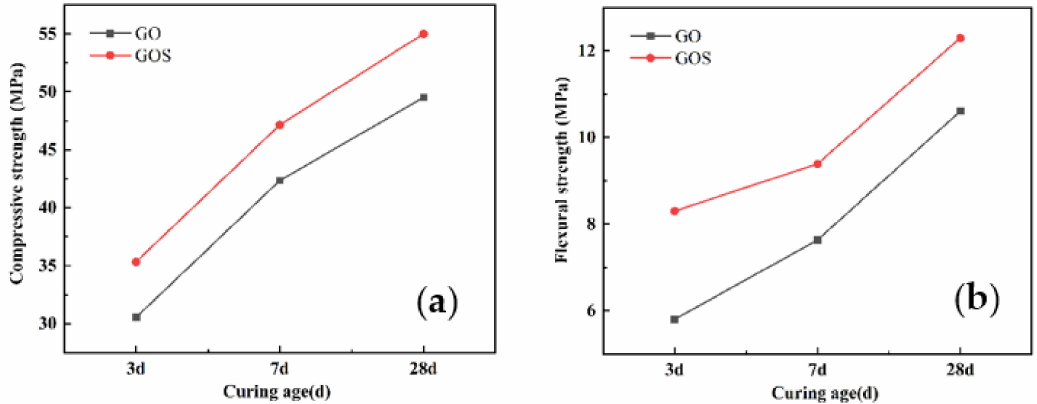
Figure 17. The strengths of the GO and GOS cement-based materials (0.01%): ( a ) compressive strength, ( b ) flexural